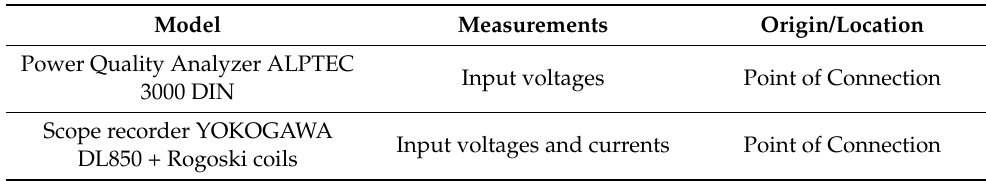
Table 1. Used measurement